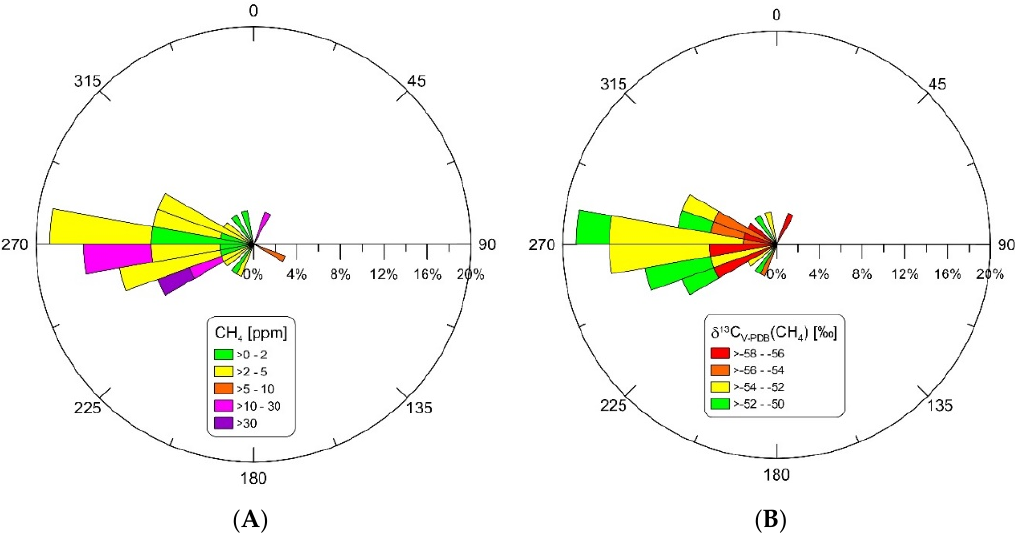
Figure 7. The circular distribution of directional data of CH 4 mole fraction ( A ) and δ 13 C(CH 4 ) values ( B ) from ambient air gathered in the vicinity of municipal waste landfill sampled during 22 August 2017 campaign.